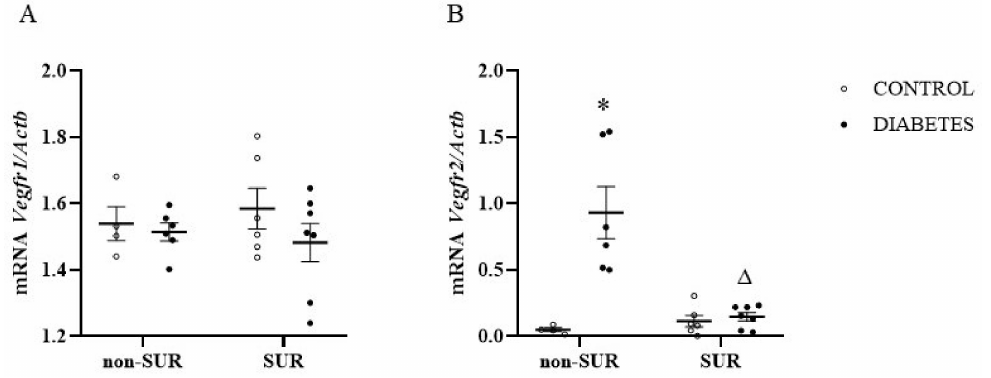
Figure 6. Effects of suramin on Vegfr1 ( A ) and Vegfr2 ( B ) mRNA expression in the renal cortex of non-diabetic and diabetic rats. Suramin (SUR, 10 mg/kg) or saline (non-SUR) were injected into non-diabetic rats (CONTROL) and streptozotocin-induced diabetic rats (DIABETES) on days 0 and +7 after streptozotocin or citrate buffer injection on day –7. Quantification of mRNA expression was normalised to the β -actin gene ( Actb ) reference transcript. The results are presented as single data points with mean values and standard errors of the mean. Statistical significance: * p = 0.0002 vs. control non-SUR, ∆ p = 0.0001 vs. diabetic SUR (two-way